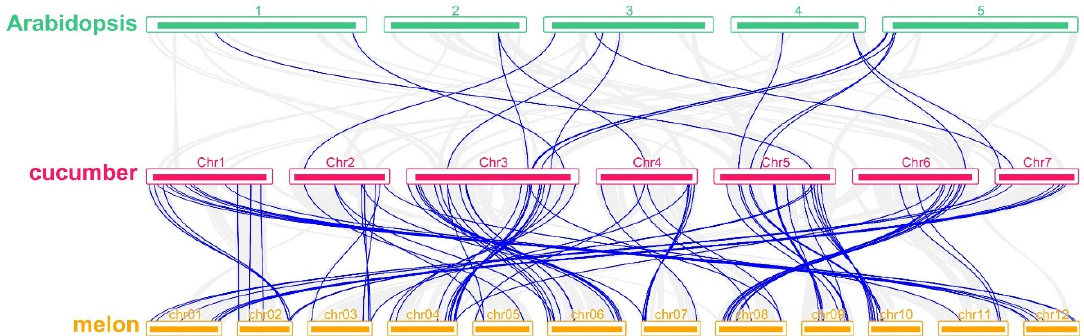
Figure 3. Collinear relationships of C2H2-ZFPs among cucumber, melon ( Cucumis melo ), and Arabidopsis . Gray lines in the background indicate collinear blocks within cucumber, melon, and Arabidopsis genomes while blue lines highlight the collinear C2H2-ZFP gene pairs.